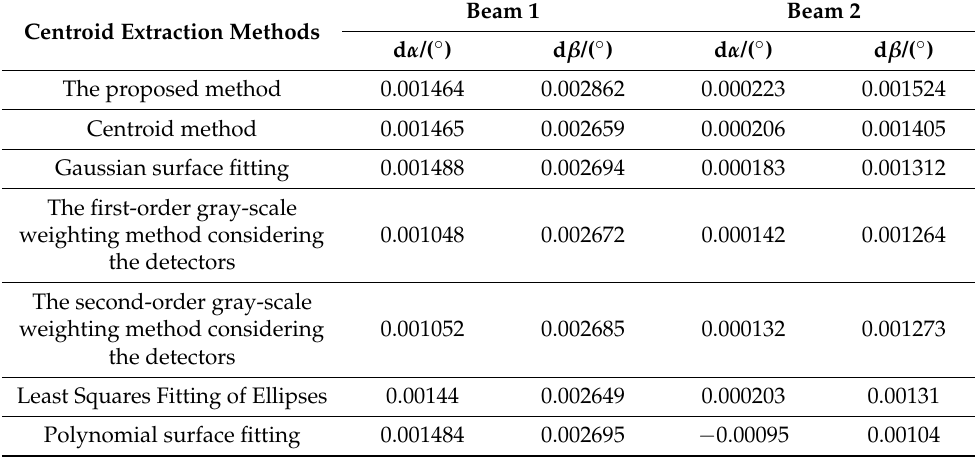
Table 2. Differences before and after elevation parameter calibration with seven different